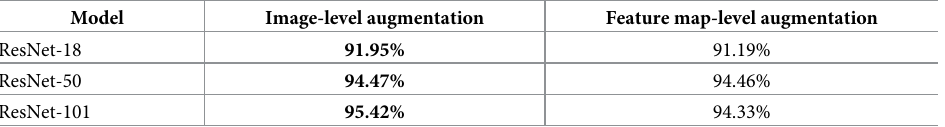
Table 6. Augmentation performance using the ResNet architecture on the CIFAR-10 dataset for classification against image and feature maps.